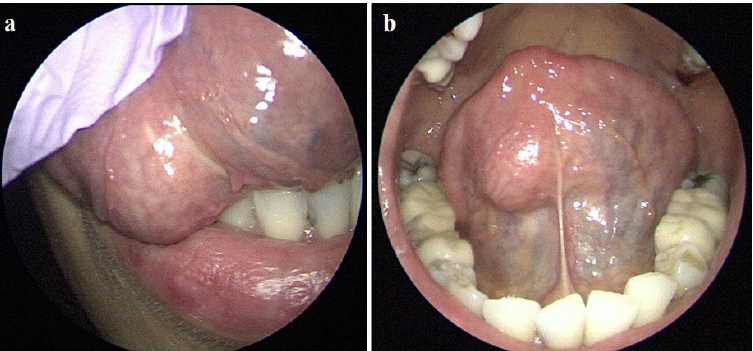
Figure 1. Laryngoscopy ( a , b ) shows a firm and fixed nodule in the right oral tongue (3 cm in maximum diameter). The overlying mucosa is intact; therefore, the nodule is considered as a submucosal lesion.